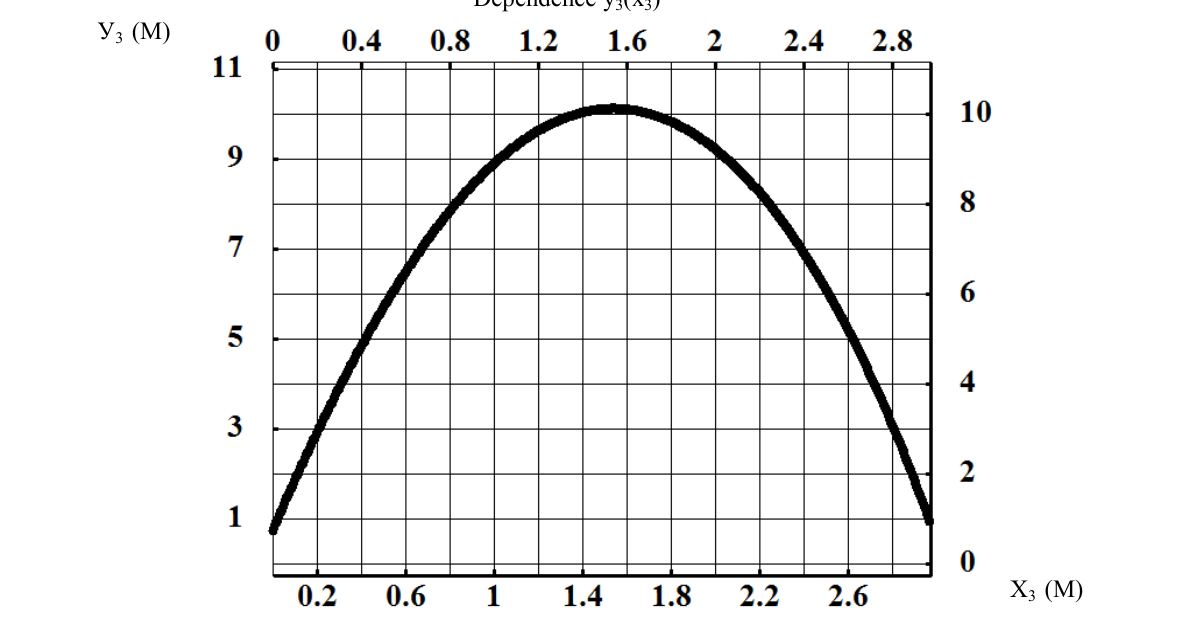
Fig.4. Graph dependence of parameters of ball flight for time t=2.75sec.; VС 0 =15m/sec; α C0 =85 0 ; h Cо =0.75m.; m=